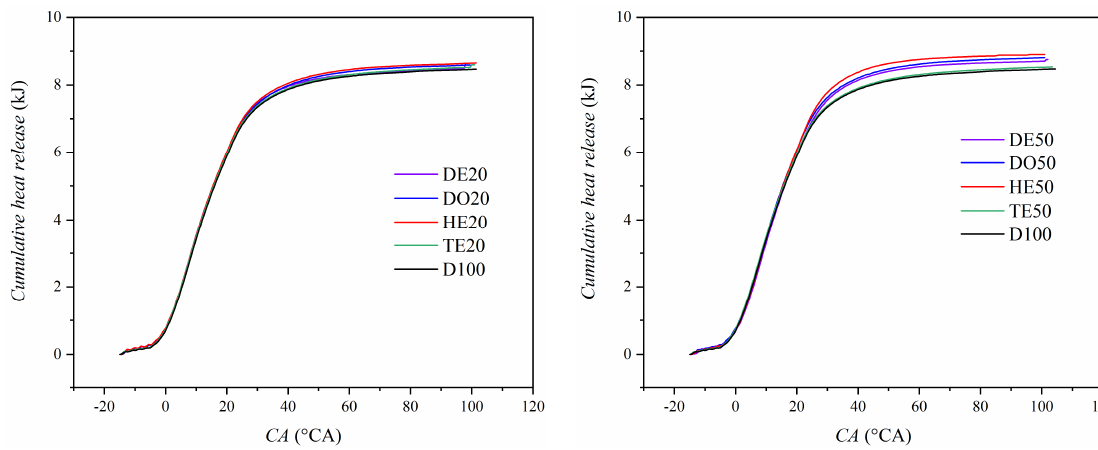
Figure 11. The cumulative heat release versus crank angles at 1900 rpm.